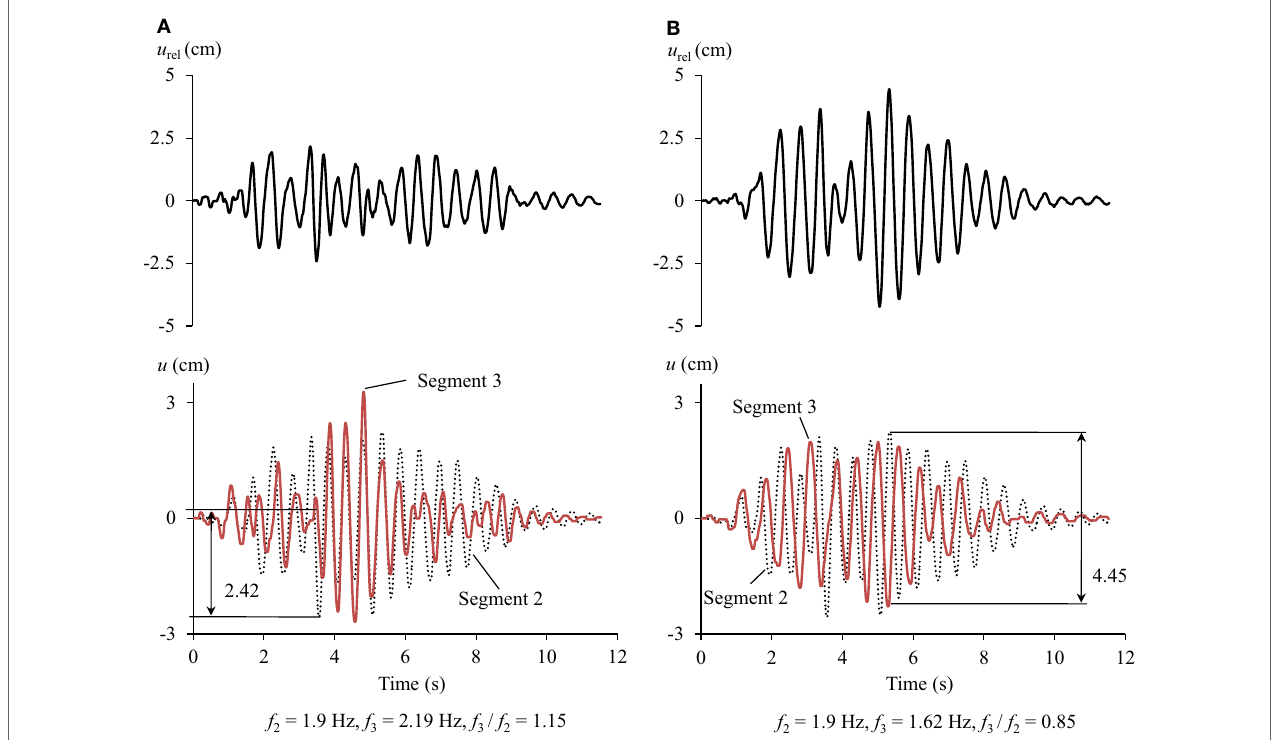
FigUre 9 | consequence of frequency ratio for the relative displacements between segments 2 and 3 due to highly correlated excitations of soft soil condition for (a) f 3 / f 2 = 1.15 and (B) f 3 / f 2 = 0.85